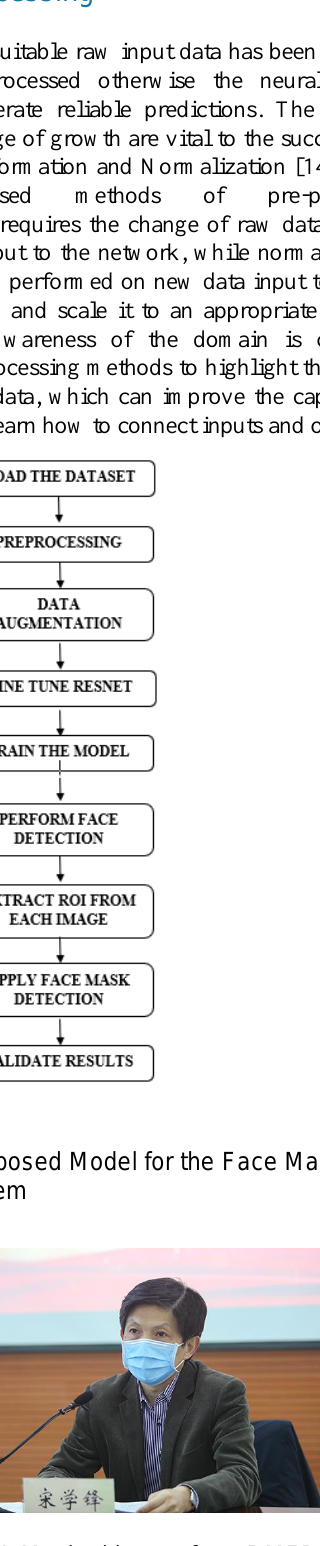
Figure 2. A Masked image from RMFRD